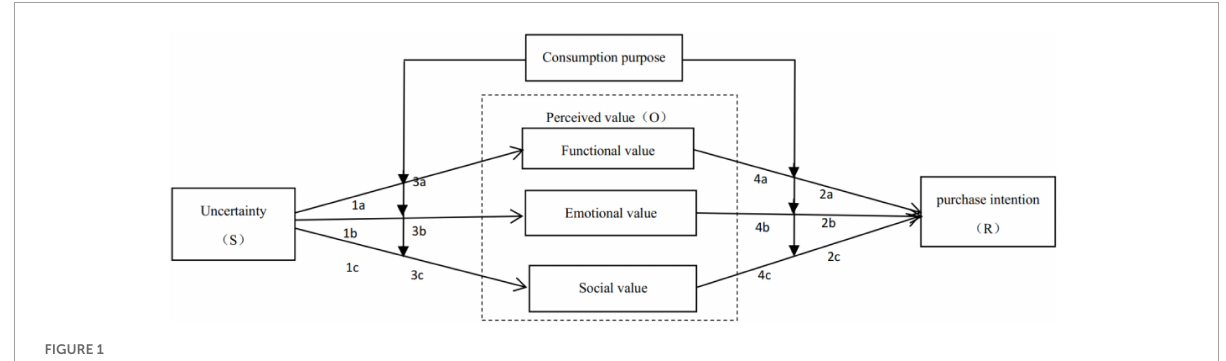
FIGURE1 Hypothetical